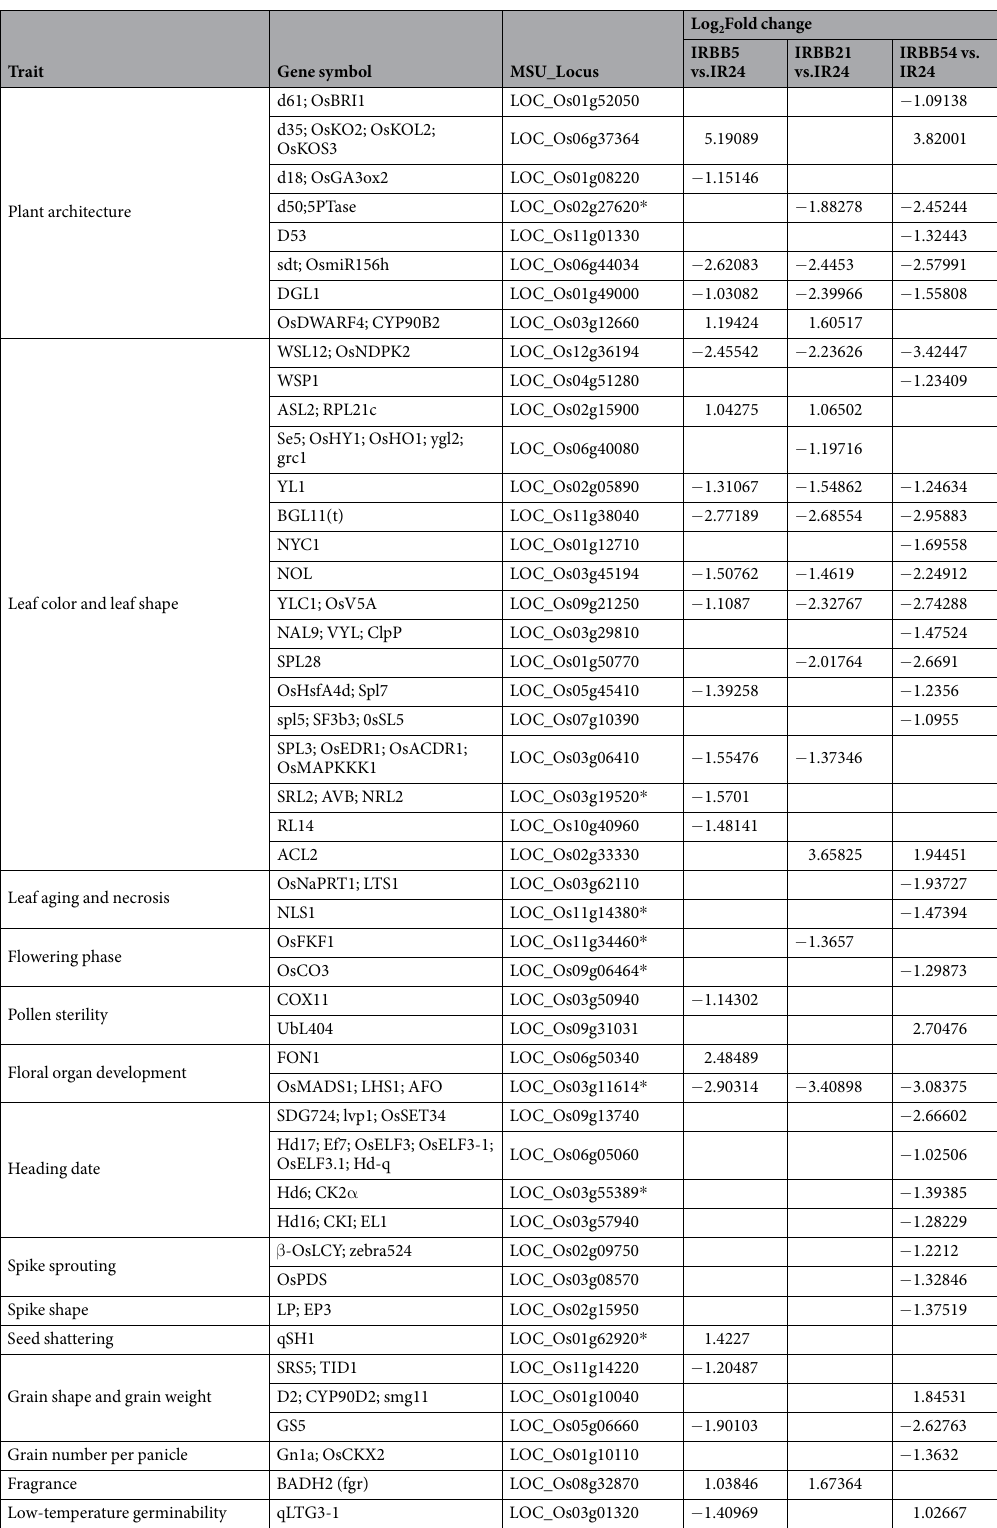
Table 2. Differentially expressed genes related to agricultural traits. Pleiotropic genes list only one trait they control. Genes that have the R-motif within their 5 ′ leader sequence, a typical motif of genes with altered translation during plant immune responses, were marked with *